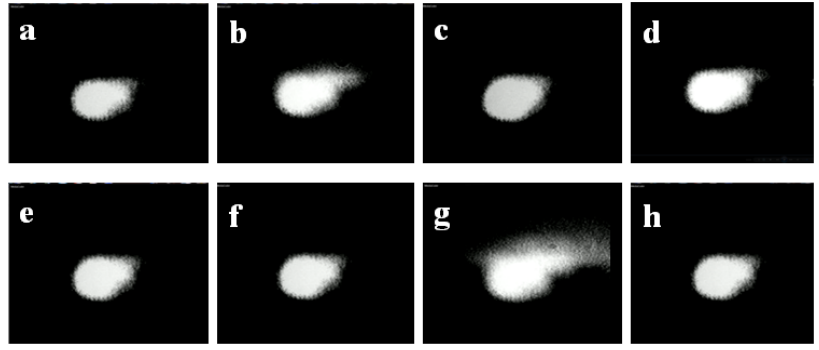
Figure 4. Snapshots of eight different consecutive pulses obtained with a single beam